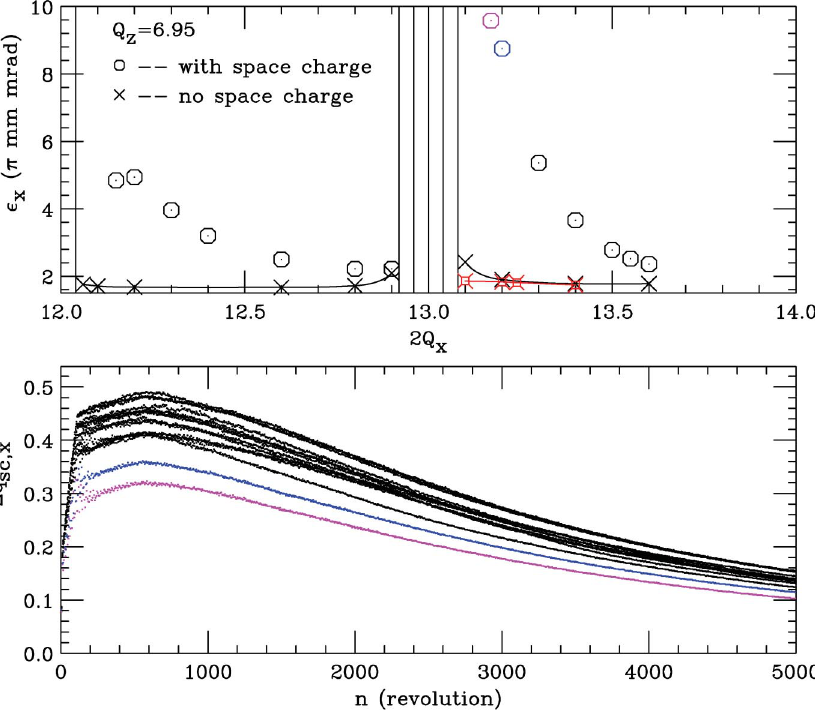
FIG. 30. (Color) Top: The final emittance for a beam with 12-turn injection under the influence of the stop band at harmonics 12 and 13. The stop band width at harmonic 12 is intentionally made small by the choice of a random seed. Bottom: the magnitude of the space-charge tune shift for all cases shown in the top plot. The blue and magenta colors correspond to the large emittance growths shown in the top plots. In these two cases, the beam distribution in the horizontal phase space becomes hollow. Note that the space charge is a self-adjusting process. When a large space-charge tune shift leads to resonance overlapping, the emittance increases so that the space-charge tune shift avoids the resonance